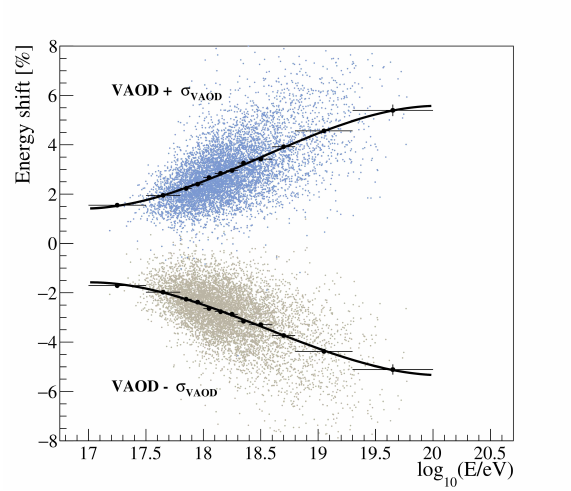
tion is approximately between -4 g / cm 2 and + 8 g / cm 2 at the highest energies.